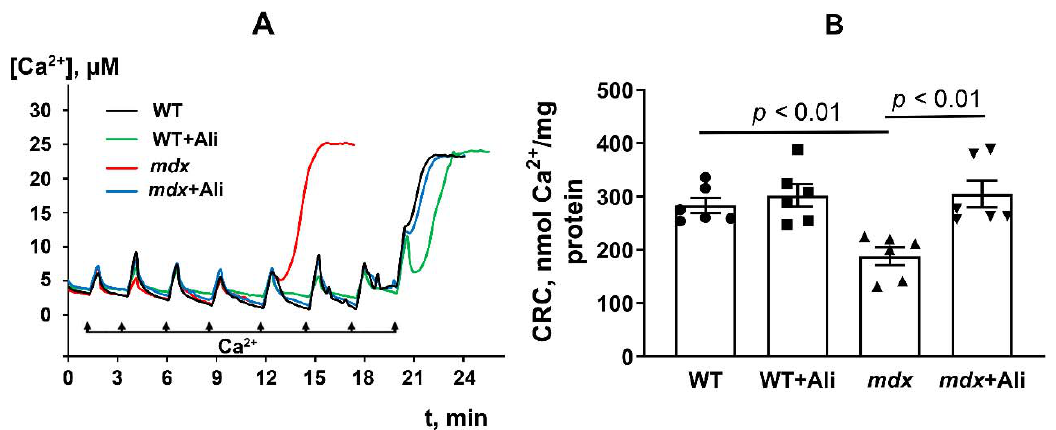
Figure 5. Changes in the external [Ca 2+ ] upon successive addition of small Ca 2+ doses (10 µ M) to the suspension of skeletal muscle mitochondria of experimental animals ( A ). Ca 2+ retention capacity of skeletal muscle mitochondria of experimental animals ( B ). The data are presented as means ± SEM ( n = 6).